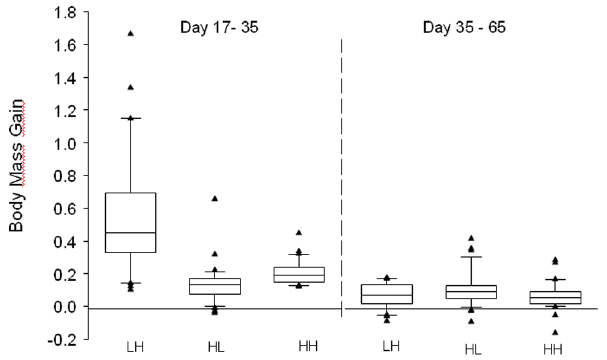
Figure 2. Body mass gain from day 17 to 35 and from day 35 to 65. Shown are medians 6 quartiles for relative change in body mass (body mass 2 – body mass 1/body mass at hatching) across the three experimental treatment groups.